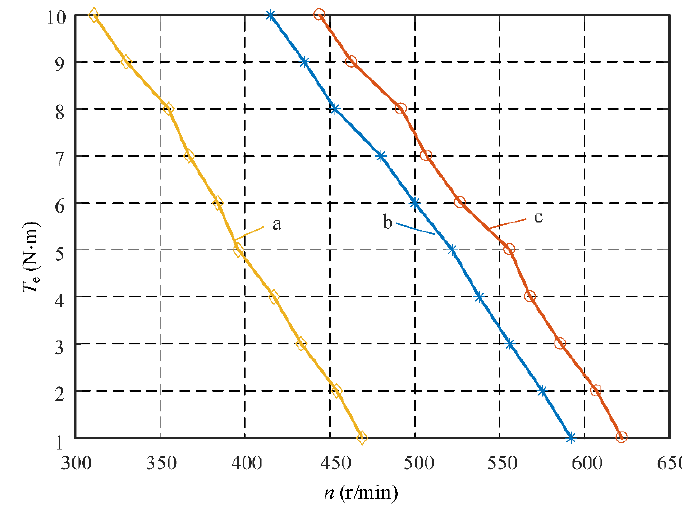
Figure 15. Experimental diagram of motor torque speed characteristic curve.